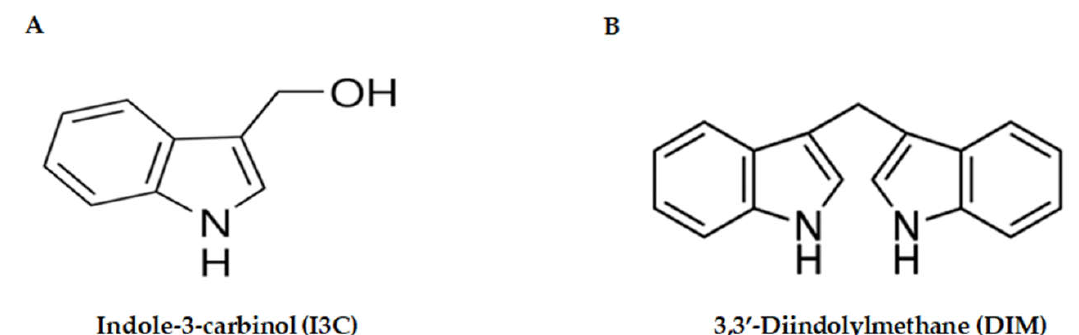
Figure 1. Molecular structures of flavonoids. ( A ) The molecular structure of indole-3-carbinol (I3C). ( B ) The molecular structure of 3,3′-diindolylmethane (DIM). DIM is a dimeric bioactive product produced by the major acid-catalyzation condensation of indole-3-carbinol (I3C) found in cruciferous vegetables.